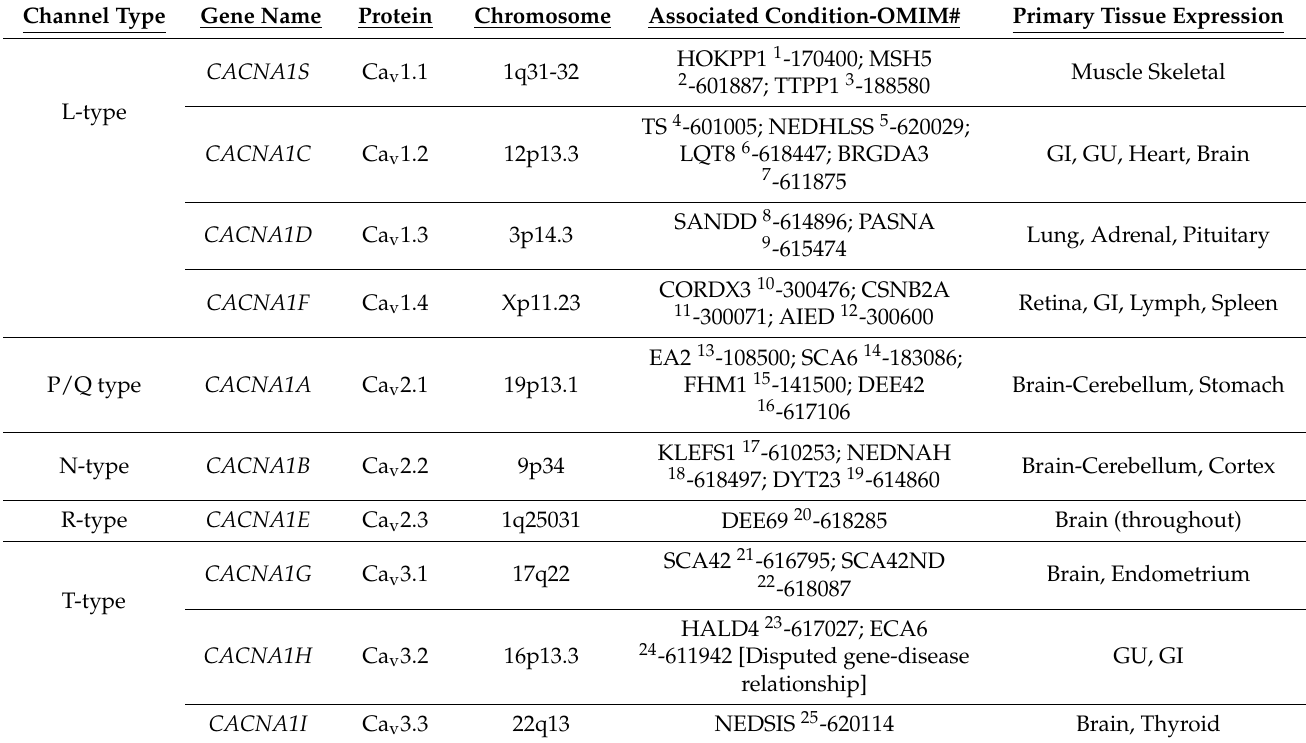
Table 1. Genes of the voltage-gated calcium channel